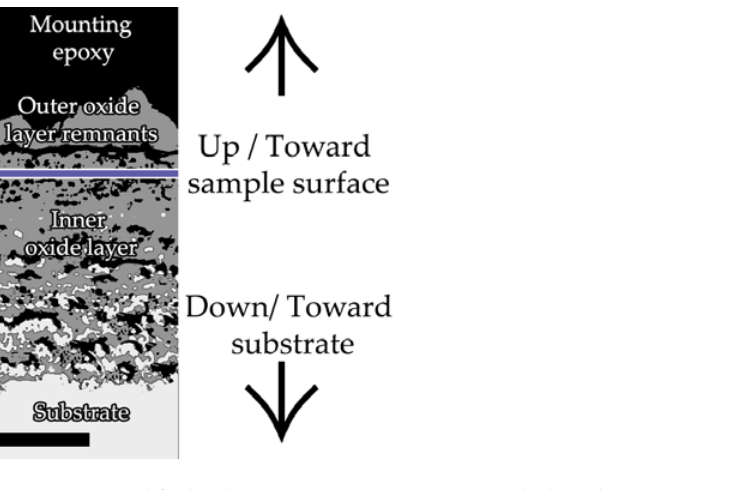
Figure 11. A modified, schematic FESEM BSE image with the substrate, inner oxide layer, outer oxide layer remnants, mounting epoxy, directions and the original sample surface marked as a horizontal purple line. Original image scale bar (black bar at the bottom of the image) is 75 μ m.